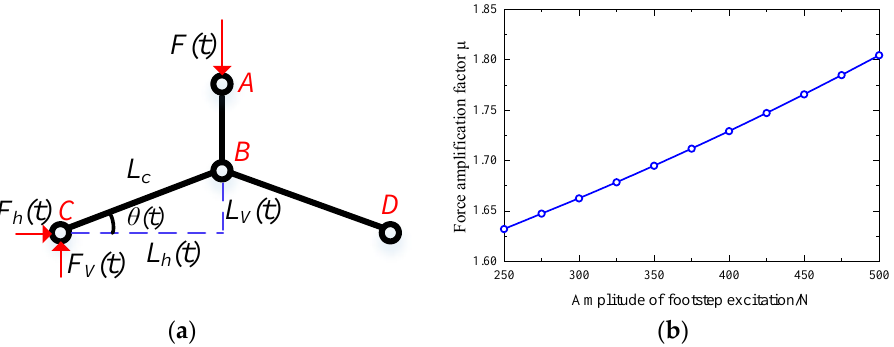
Figure 2. Physical simplified model of the force amplifier and the force amplification factor versus the footstep excitation amplitude. ( a ) Simplified model of force amplifier; ( b ) Force amplification factor ( L = 33.5 mm).